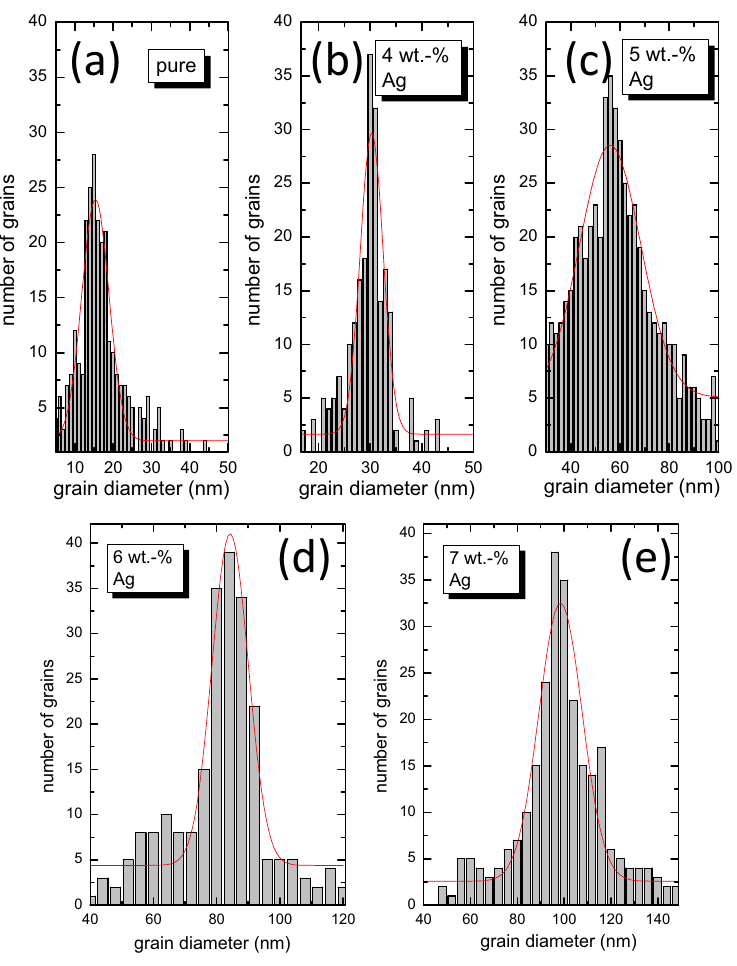
Figure 2. Grain diameter statistics for all five polycrystalline FeSe samples with Ag addition studied here, ( a ) pure, ( b ) 4 wt.-% Ag, ( c ) 5 wt.-% Ag, ( d ) 6 wt.-% Ag, and ( e ) 7 wt.-% Ag.